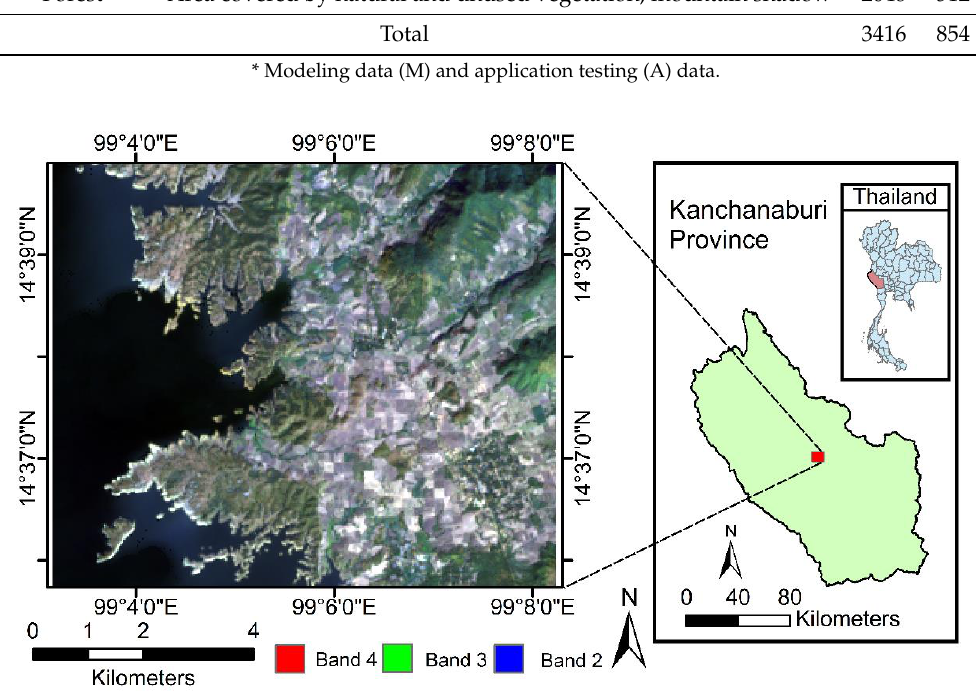
Figure 2. True color image of the study area.